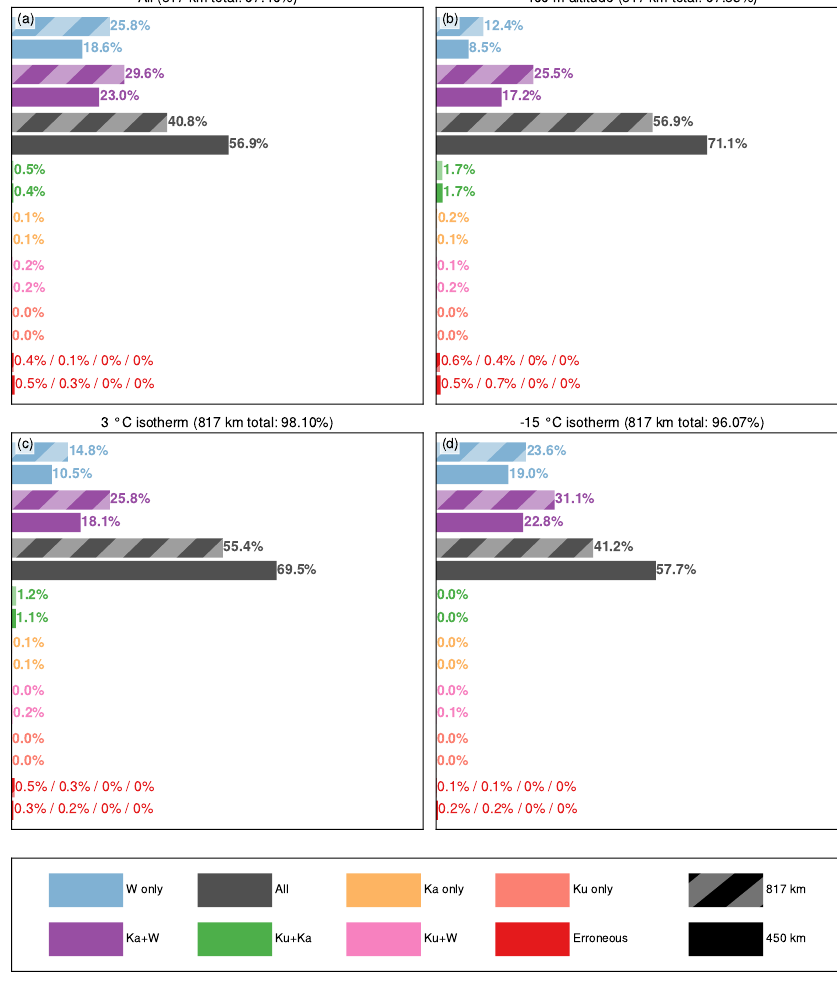
Figure 17. As in Fig. 4, but limited to the region of Fig. 16 (Sect. 5.7; FRO in Fig. 3).